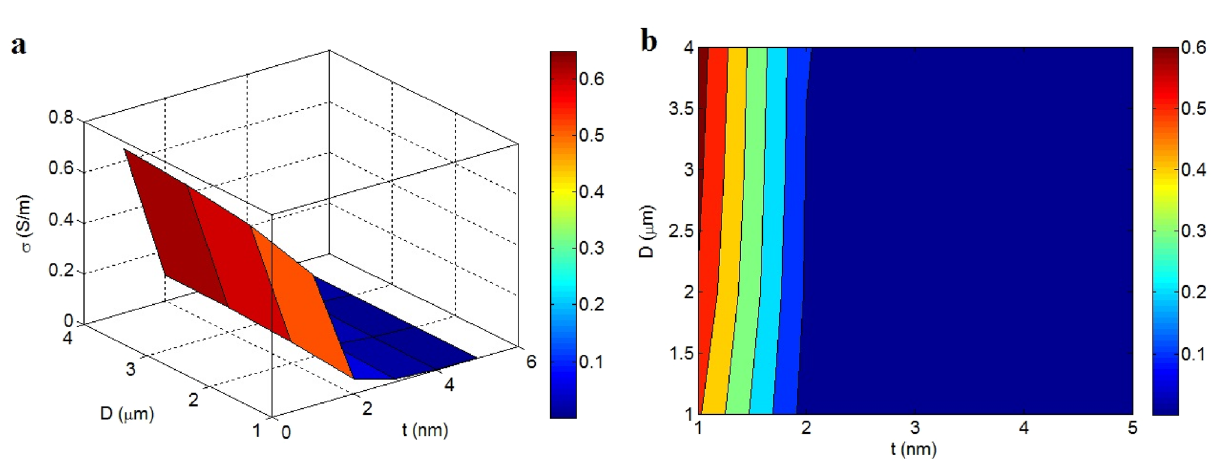
Figure 3. Conductivity of nanocomposite at altered levels of “ φ p ” and “σ f ” ( φ f = 0.01, t = 2 nm, t i = 4 nm, d = 5 nm and K = 2) by ( a ) 3D and ( b ) contour schemes.